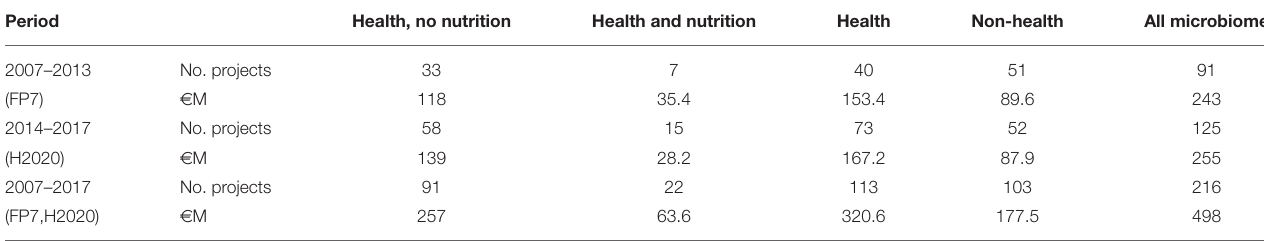
TABLE 1 | Number of EU-funded projects with budget for different research areas and